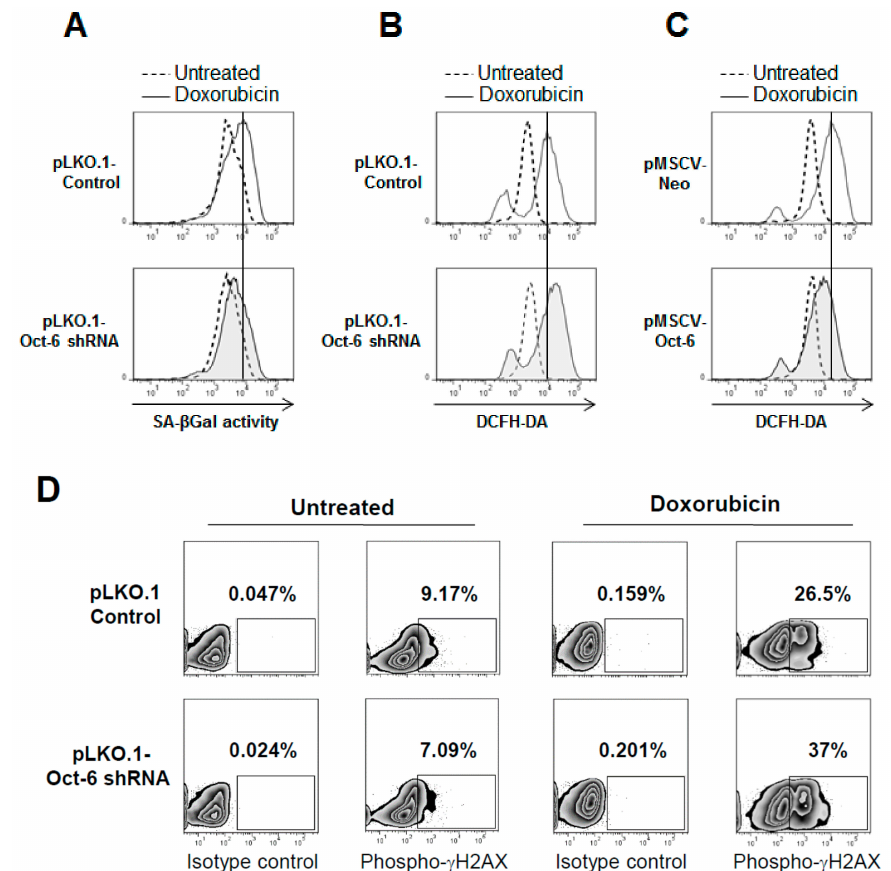
Figure 4. Oct-6 regulates drug-induced senescence, ROS generation, and DNA damage. ( A ) Control (black histogram) or Oct-6 silenced H460 cells (grey colored), left untreated ( − ) or treated with Dox 0.5 µ M for 48 h, were left 1 h with 100 nM of bafilomycin A1 to induce lysosomal alkalization, followed by 1 h of incubation with C 12 FDG (33 mM), to analyze the percentage of senescence-associated β -galactosidase (SA- β Gal) positive cells by flow cytometry. ( B ) Intracellular ROS production was measured by staining pLKO-shRNA-Oct-6 (black histogram) or non-target shRNA infected H460 cells (grey colored) upon 48 h drug treatment with 10 µ M DCFH-DA, as described in Materials and Methods, and analyzed by flow cytometry. ( C ) Intracellular ROS levels in H460 cells stably transduced with the retroviral expression vector pMSCV-Oct-6 or pMSCV-Neo unstimulated (grey colored), or treated with Dox (0.5 µ M), (black histogram) for 48 h were evaluated by FACs analysis, as described above. The histograms shown in the figure are representative of various independent experiments, all displaying similar results. ( D ) The phosphorylation of γ H2AX was evaluated by immunofluorescence and FACS analysis, by staining pLKO-shRNA-Oct-6 or non-target shRNA infected H460 cells with anti- γ H2AX or anti-cIgG after 48 h exposure to Dox. All of the results shown are representative of one out of three independent